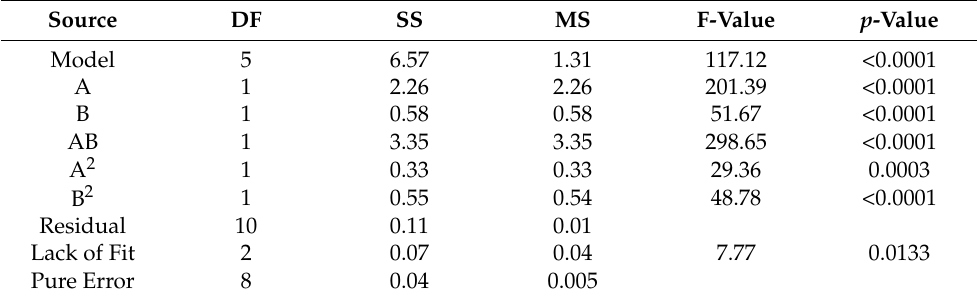
Table 4. ANOVA analysis for SUB-RAW index responses obtained from the reprocessing of the experimental